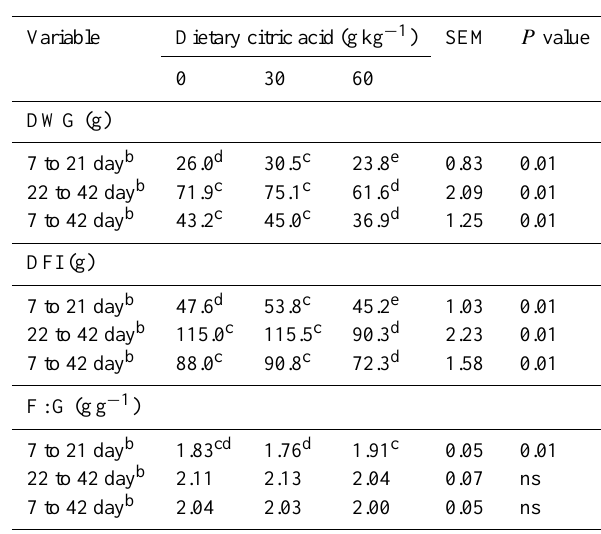
Table 2. Effect of citric acid on daily weight gain (DWG), daily feed intake (DFI) and feed intake per weight gain (F:G) in broiler chicks from 7 to 42 days of age a .